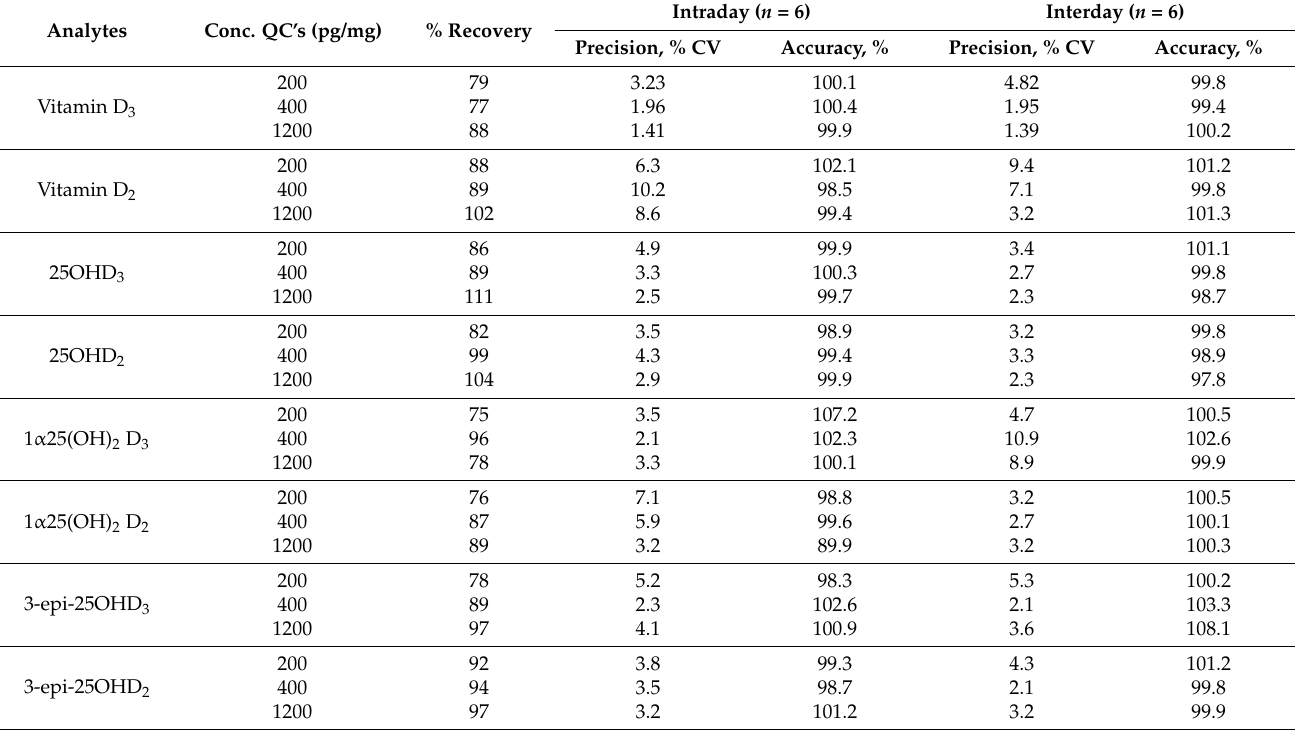
Table 2. Method validation results for intraday/interday precision, accuracy, and recovery.